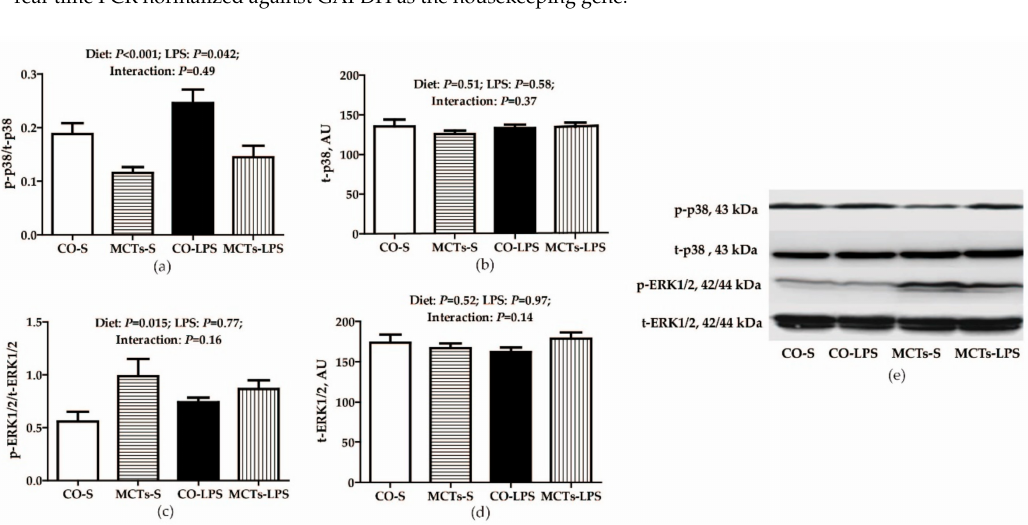
Figure 5. Effect of medium-chain triglyceride (MCT) supplementation on liver p38 ( a , b ) and extracellular signal-related kinase 1/2 (ERK1/2) ( c , d ) phosphorylation levels after 4-h LPS